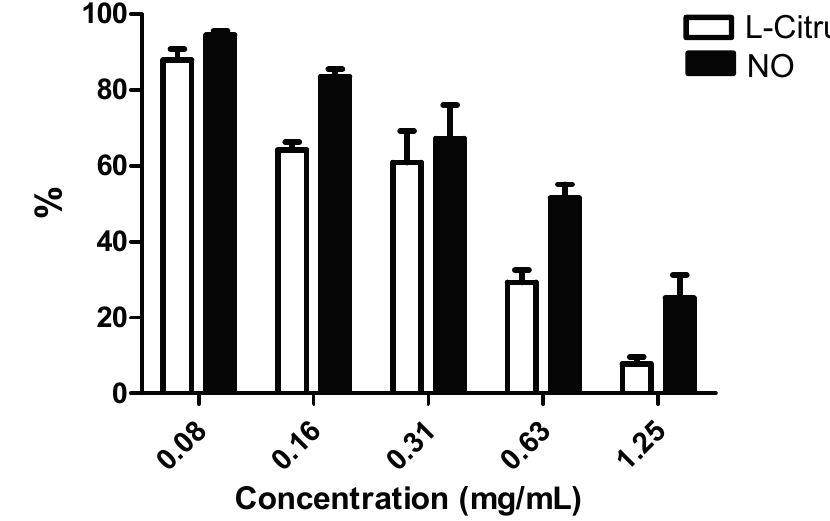
Figure 5. NO and L-citrulline levels on RAW 264.7 cells pre-treated for 1 h with